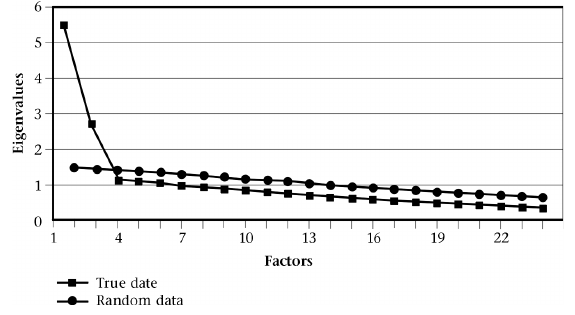
Figure 1: Scree plot second language T ABLE 6 F ACTOR EIGEN VALUES AND VARIANCE EXPLAINED FOR